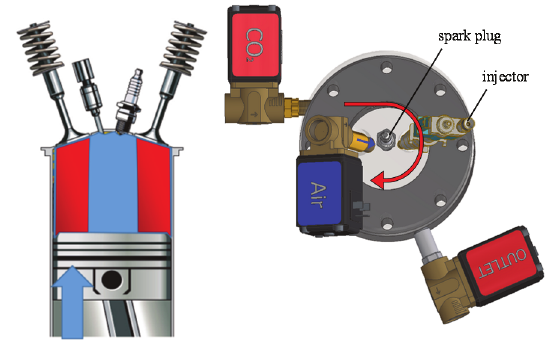
Fig. 4. The concept of radial layering of non-flammable (red) and flamma- ble (blue) gases with the visualization of the injection method (using